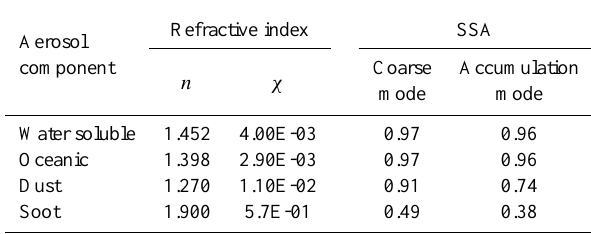
Fig. 1. Phase functions for coarse mode of oceanic, water soluble, dust and soot aerosol components calculated for spherical polydis- perse particle at 550nm (VIS, continuous line in the figure) and 3.7µm (IR, dashed line in the figure). The phase functions are nor- malized to unity, see SSA in text.